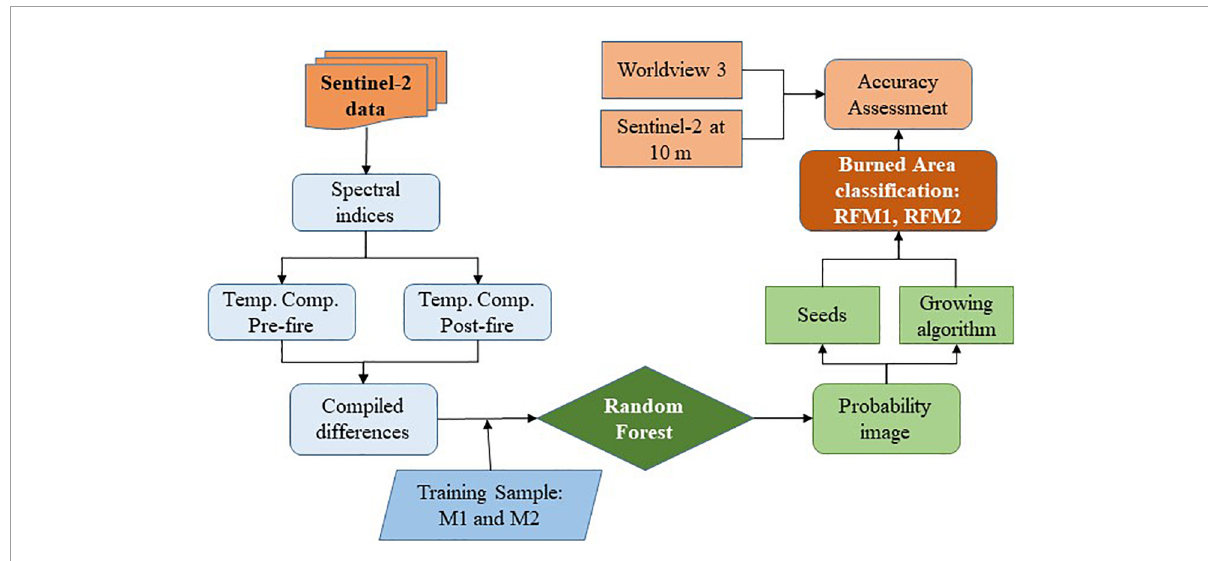
FIGURE2 Methodological workflow applied in this study to produce burned area classification.